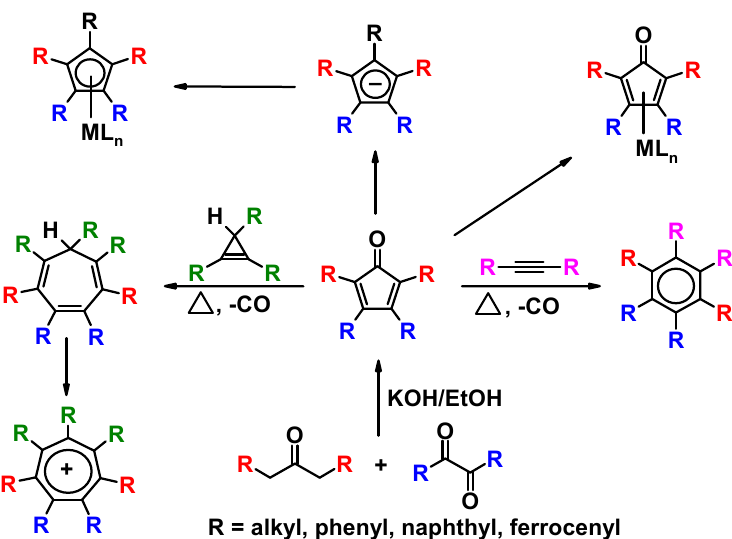
Scheme 5. Cyclopentadienones as precursors to five, six and seven-membered ring